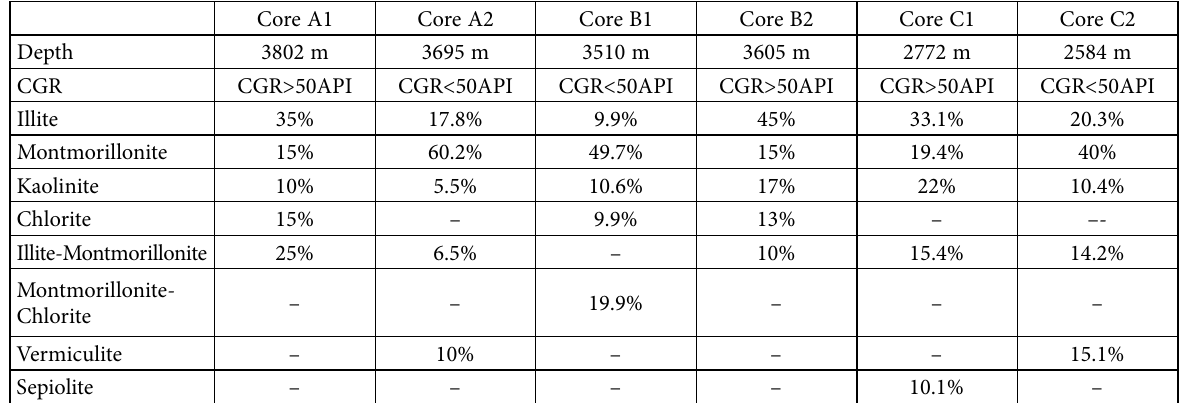
Table 3. Results of XRD tests on